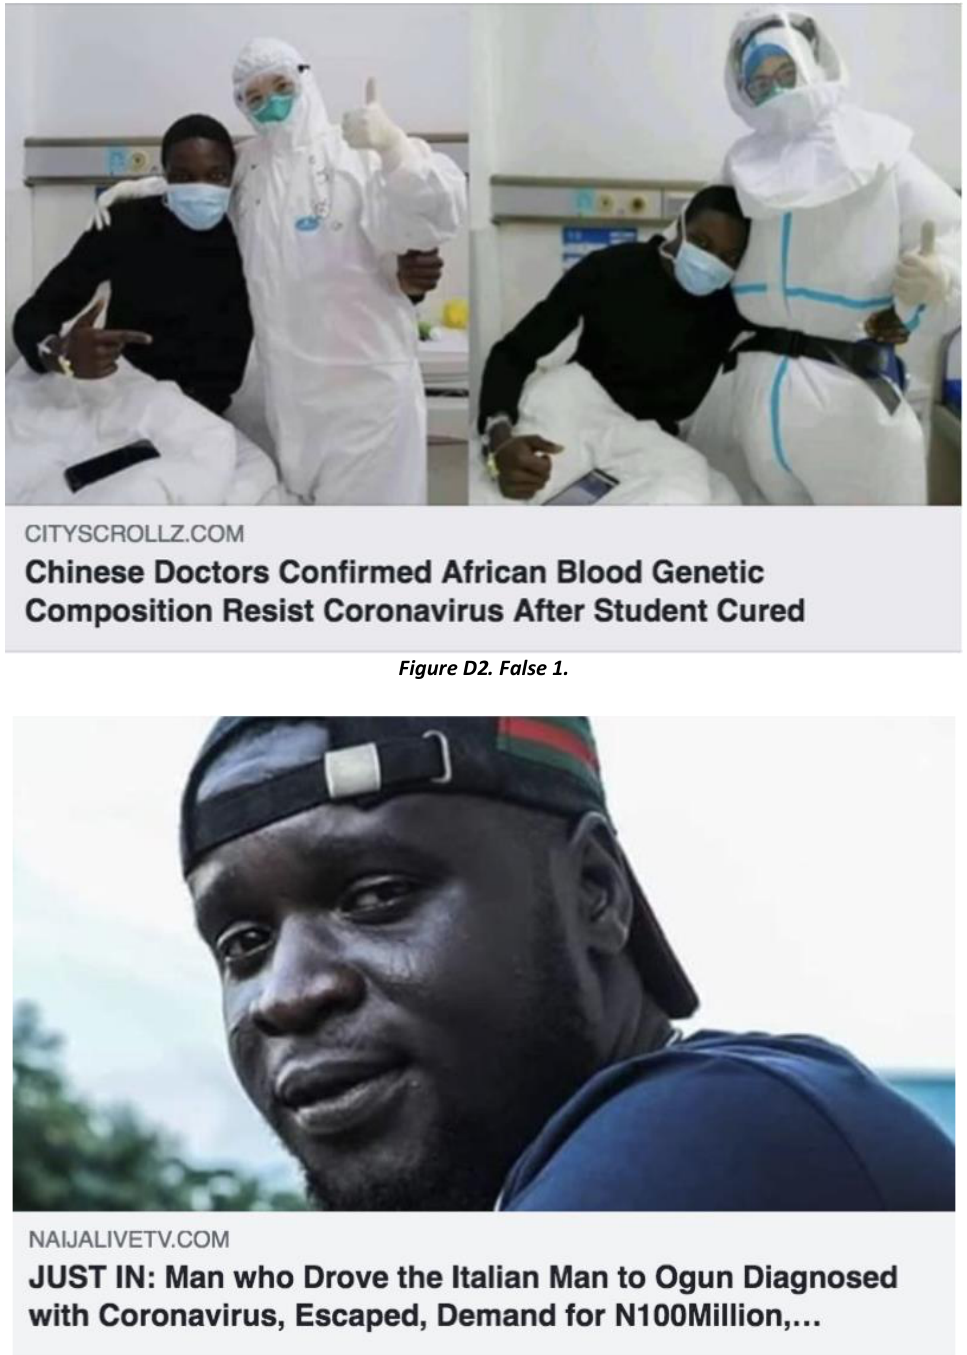
Figure D3. False